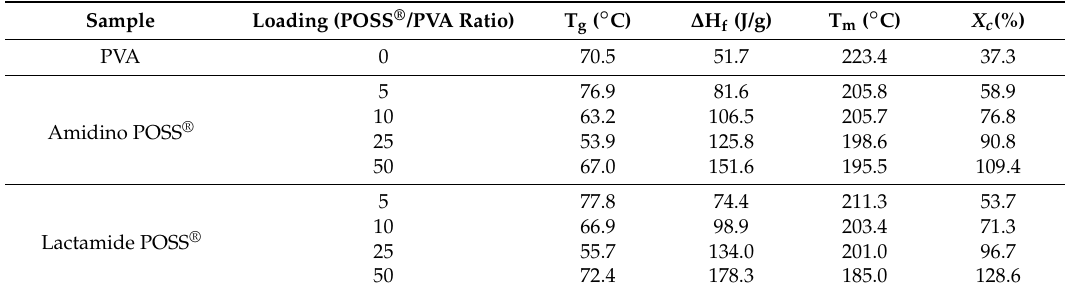
Table 2. Glass transition temperatures, enthalpy and melting temperature, and degree of crystallinity of the different nanocomposite membranes.